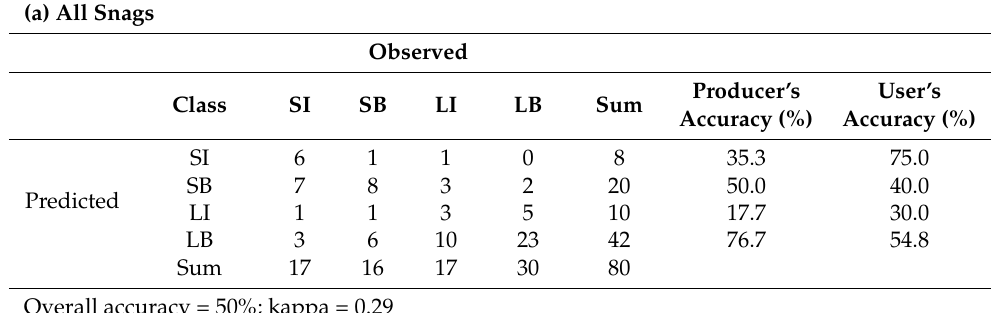
Top predictor variables: P3rdRN, LADcv, ELEV